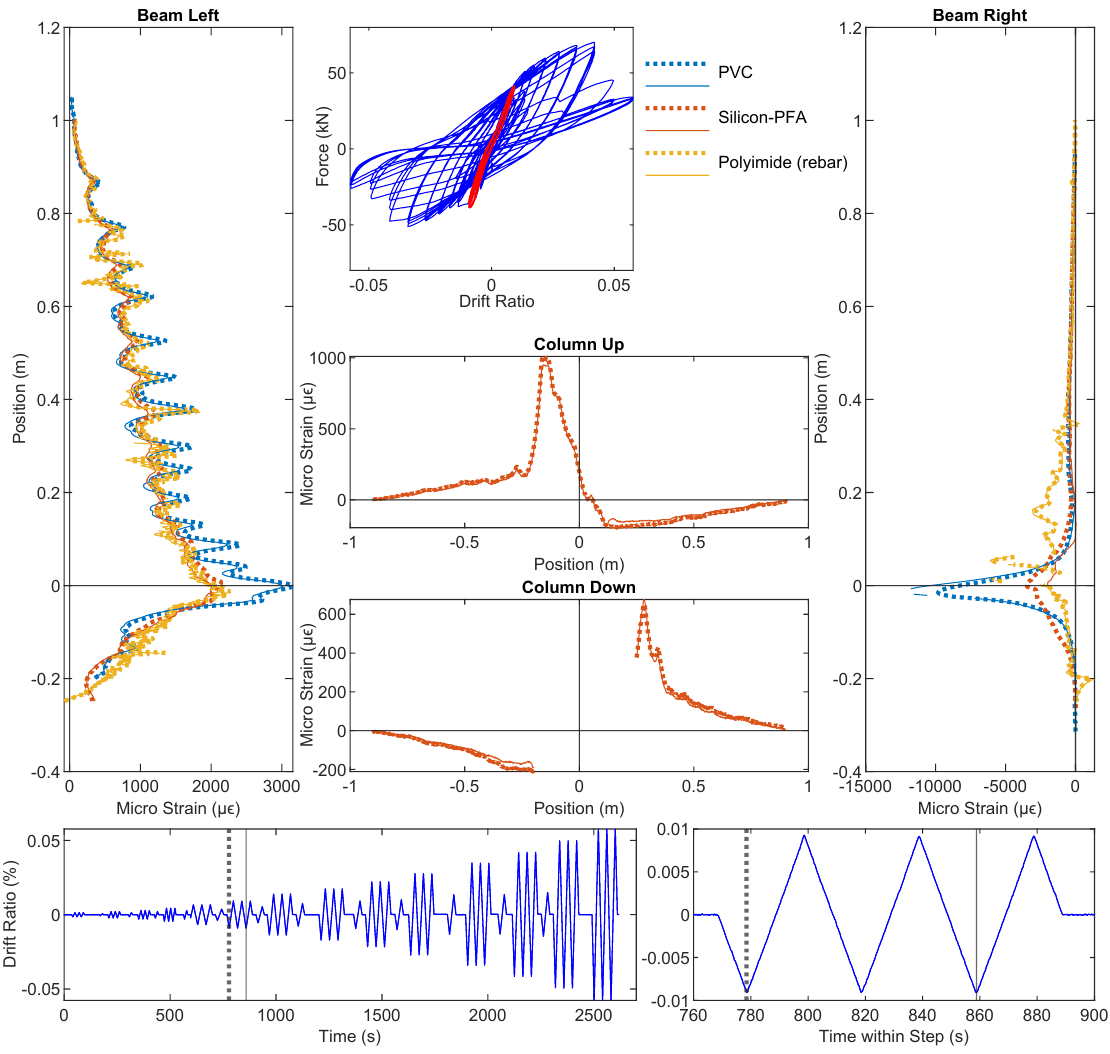
Figure 8. DFOS results at a drift level of −